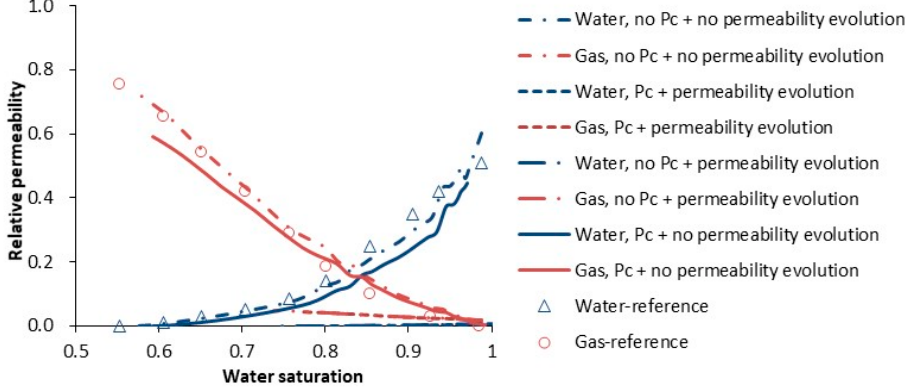
Figure 13. Effects of varying factors on the interpretation of results recovered from the JBN